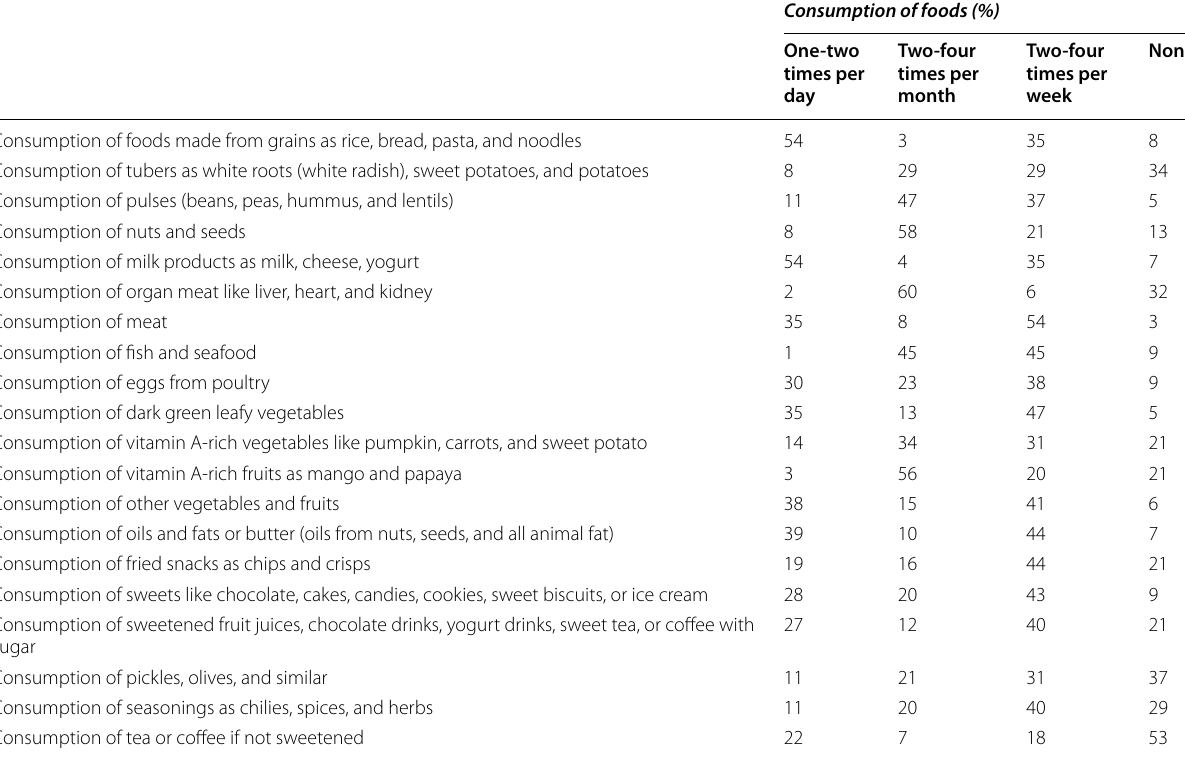
Table 2 The frequency distribution of food